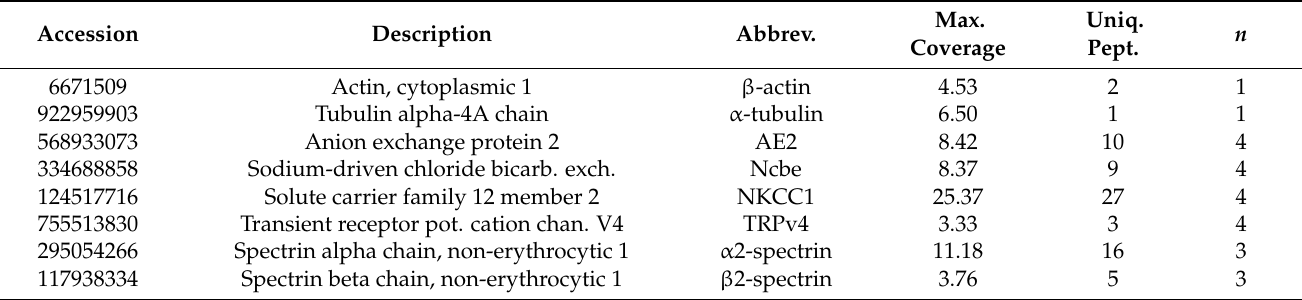
Table 4. Coomassie band at NKCC1, AE2, Ncbe immunoreactive band on native PAGE blot. Maximum sequence coverage (Max. Coverage), Unique peptides (Uniq. Pept.), number of identifications (of five replicates, n ). Accession Description Abbrev.